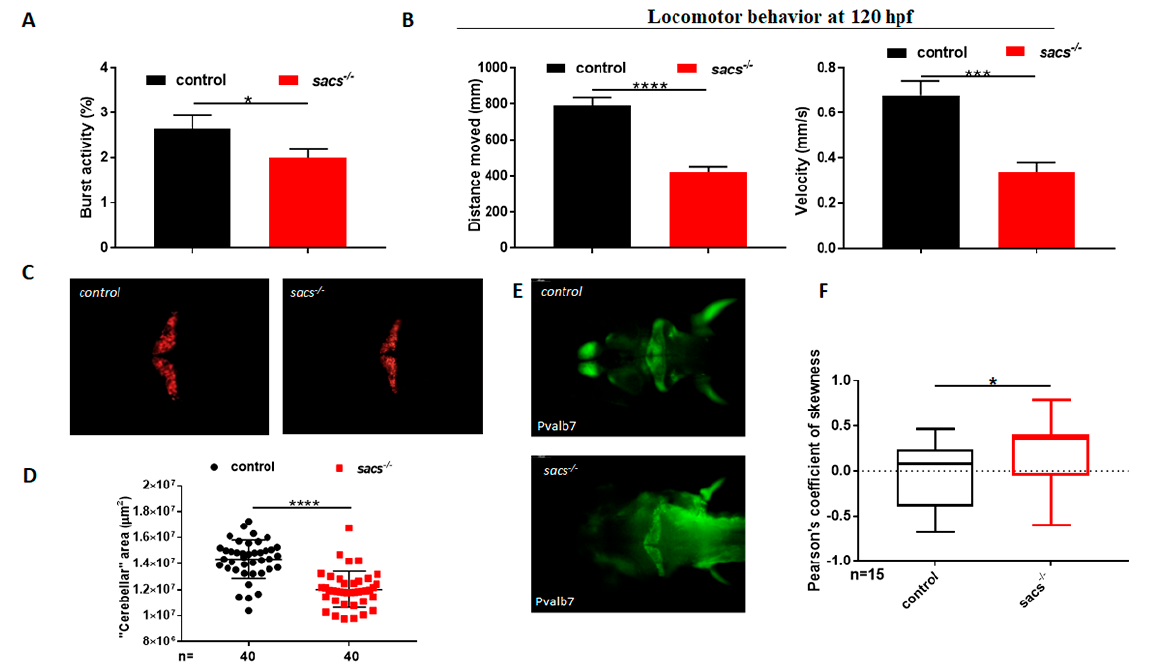
Figure 2. sacs − / − mutant zebrafish display motor impairment and reduced cerebellar area. ( A ) Coiling frequency in zebrafish embryos at 30 hpf is decreased in sacs − / − compared with control specimens ( sacs − / − n = 113; controls n = 113, in 4 independent experiments). ( B ) Automated analysis of spontaneous motor activity revealed a reduction in swim distance and velocity in sacs − / − larvae at 120 hpf compared with observations in control siblings ( sacs − / − n = 256; controls n = 273, in 5 independent experiments). Statistical analysis (* p ≤ 0.05, *** p ≤ 0.001, **** p ≤ 0.0001) was performed using the Mann-Whitney test. ( C ) “Cerebellar” morphology as assessed in vivo by RFP fluorescence in Tg(tagRFP-T:PC:GCaMP5G). The “cerebellar” area was found to be significantly reduced in sacs − / − compared with control specimens at 120 hpf. ( D ) Statistical analysis of the data shown in ( C ), **** p ≤ 0.00001, calculated by the Mann-Whitney test. The values are expressed as mean ± standard deviation. ( E ) Dorsal views at 120 hpf of whole-mount larvae labeled with mAB pvalb7 ( sacs − / − n = 20; controls n = 20). ( F ) Pearson’s coefficient of skewness of the distribution of the fluorescence fluctuations, ∆ F/F0. These statistics are cumulated from 16 recordings in controls and sacs − / − mutants, respectively. (* p ≤ 0.05 was calculated using the Mann-Whitney test). Abbreviations: n , number of evaluated embryos in total; error bars indicate standard errors of the means .